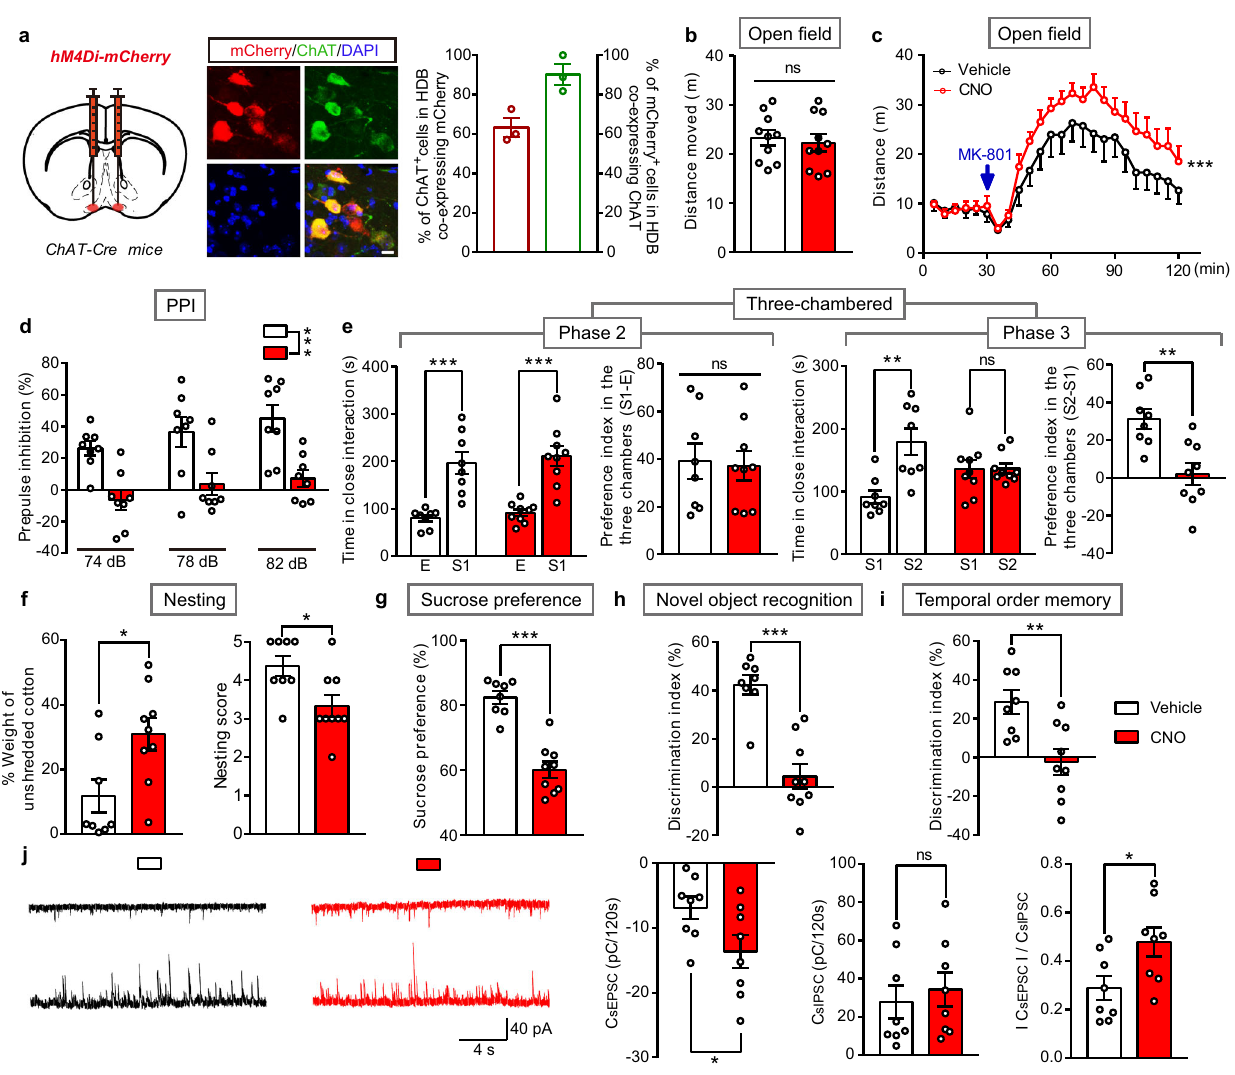
Fig. 6 Chemogenetic inhibition of cholinergic neurons in the BF induces sensorimotor gating ability de fi cit, social impairments, anhedonia-like behavior, and cognitive impairments, together with increased susceptibility to MK-801 induced hyperlocomotion. a Schematic diagram of microinjection of AAV-EF1 α -DIO-hM4Di-mCherry (hM4Di-mCherry) in the HDB of BF in ChAT-Cre mice, and representative images of hM4Di-mCherry expression in HDB ChAT + cholinergic neurons. The percentage of ChAT + cholinergic cells co-expressing mCherry and percentage of mCherry expressed in cells co-labeling ChAT were quanti fi ed. Scale bar, 10 μ m. n = 3 mice. b – i Locomotion, sensorimotor gating, social behavior, hedonic function, and cognitive behavior in ChAT-Cre mice injected with hM4Di-mCherry in the HDB and treated with CNO or vehicle. b The cumulative distance traveled in the open fi eld for 15 min in locomotion test. c The distance traveled in the open fi eld for every 5 min was quanti fi ed and MK-801 was administrated 30 min after the free exploration phase. d Percentage of prepulse inhibition of the auditory startle re fl ex across different prepulse intensities. e Time in close interaction and preference index during sociability testing (phase 2), when exposed to a stranger mouse S1. Time in close interaction and preference index